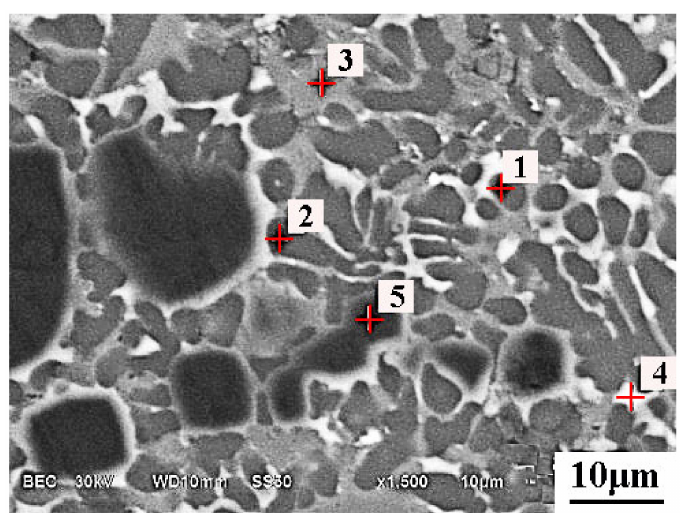
Figure 6. XRD pattern of dephosphorization slag in Heat 2.